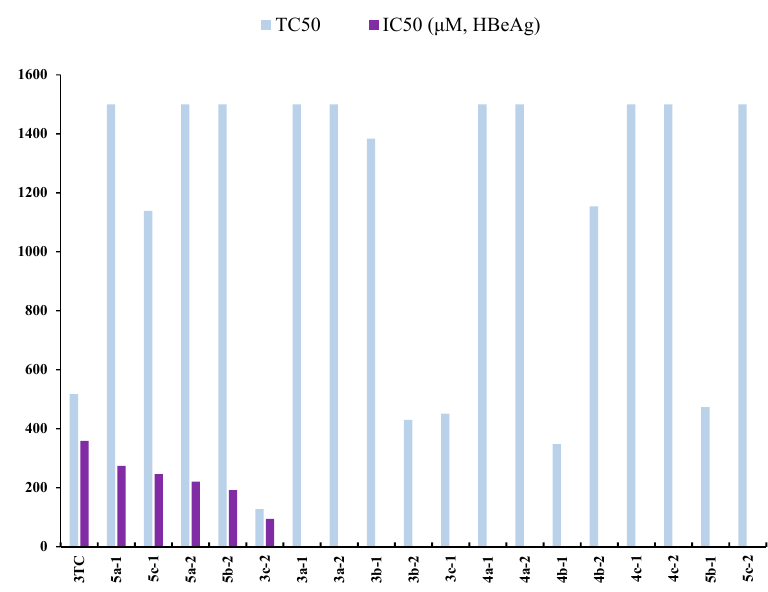
Figure 6. Cytotoxicity and inhibiting HBeAg activity of compounds in 9 days.